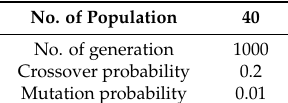
Table 4. GA parameters.